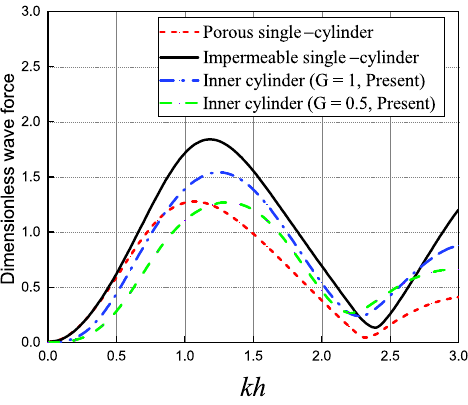
Figure 14. Comparison of wave forces between the single cylinder and the inner cylinder of the concentric system near a vertical wall with e / a = 1, β = 0, h / a = 1.5 and c / a =